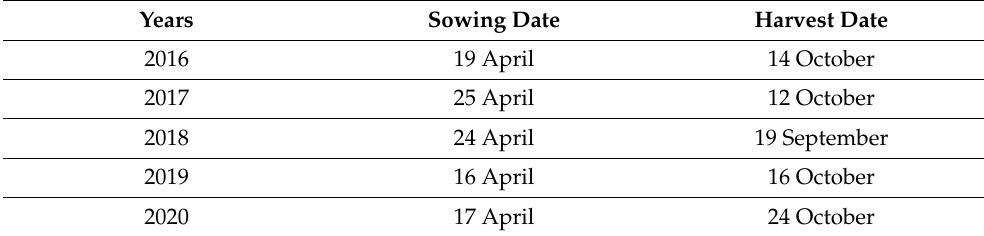
Table 7. Sowing and harvest dates between 2016 and 2020